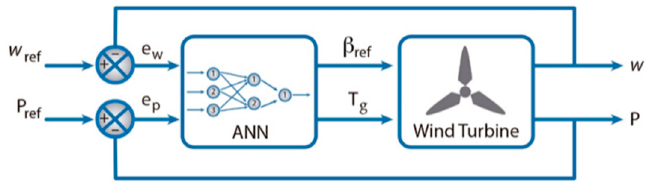
Figure 16. ANN control strategy, acts on the control pitch and the speed of the generator. Uses as input, the error in the generator speed and the power generated [74].